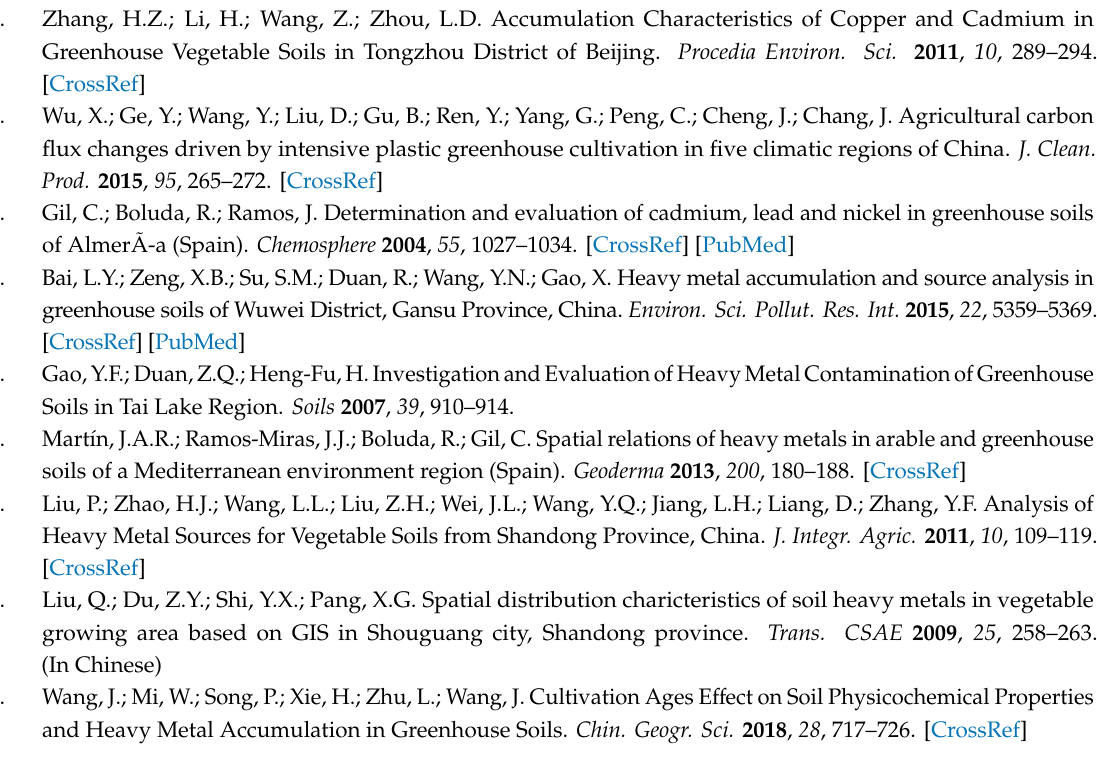
Table S1: Basic information of sampling sites of this study; Table S2: Total variance explained for heavy metal contents based on PCA analysis; Table S3: Annual heavy metal input to greenhouse soils in Shouguang. Author Contributions: Conceptualization, Y.C.; Data curation, Z.L.; Formal analysis, Z.L.; Funding